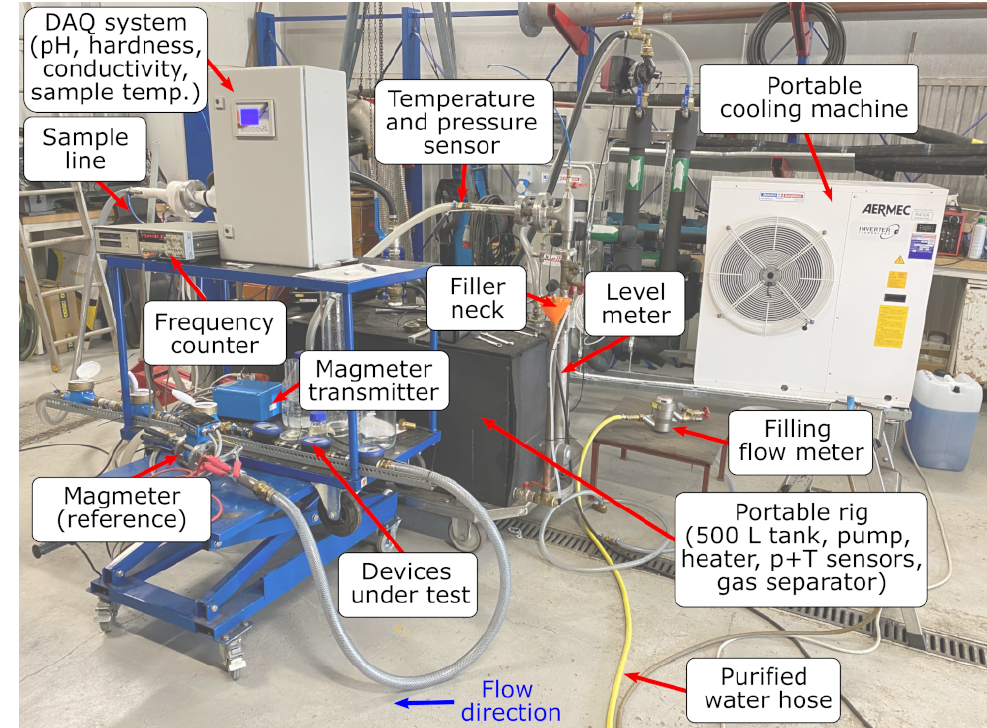
Figure 2. Overview of the wear test